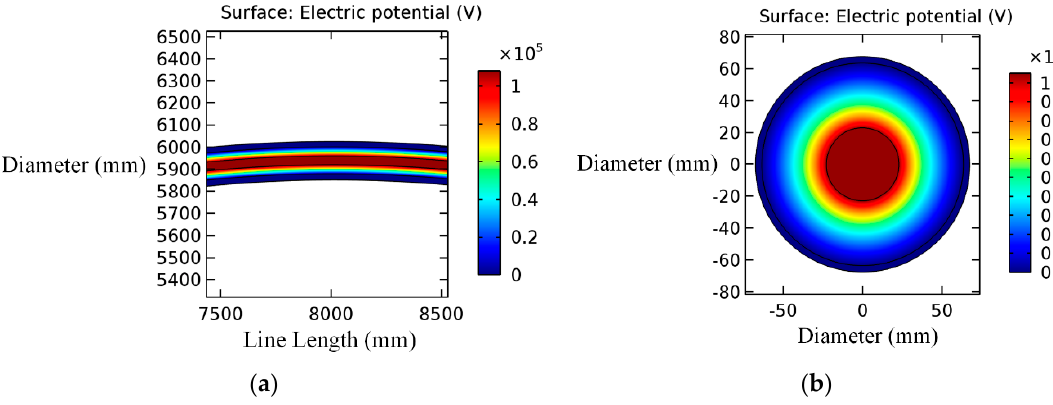
Figure 21. Potential distribution in bended segment of proposed PE 100 based FGIL scheme regarding ( a ) axial and ( b ) radial cross-sections.